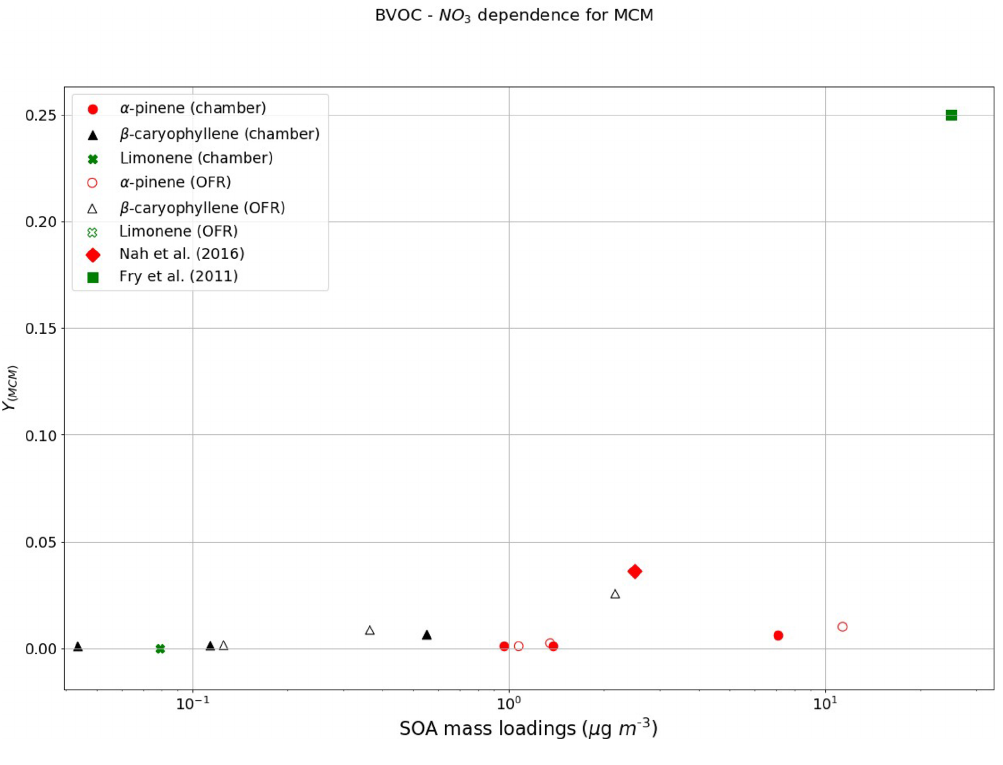
Figure 5. The mass yields from NO 3 oxidation of BVOCs modeled after chamber and flow-tube settings. The figure shows a compar- ison of SOA mass yields obtained from application of MCM. Appreciable mass yields were only obtained for α -pinene, limonene and β -caryophyllene.